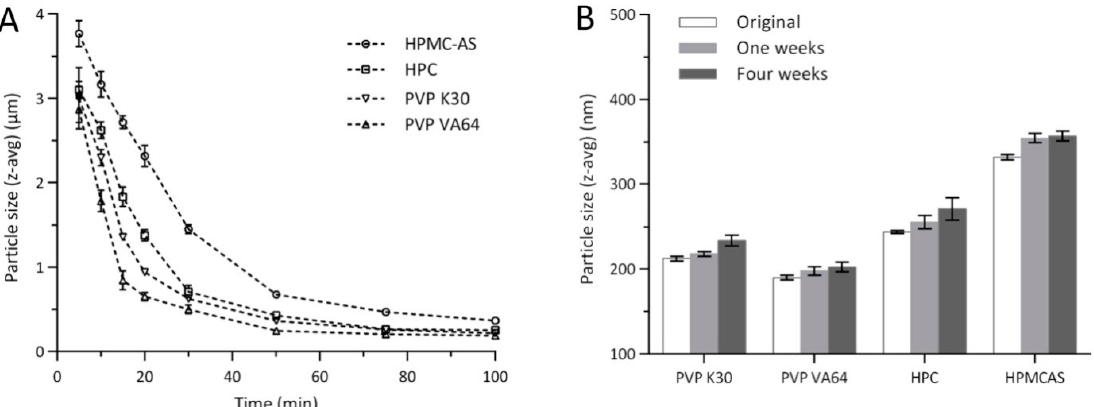
Figure 1. Particle size distributions during ( A ) milling process and ( B ) short-term storage process of celecoxib nanocrystalline (CLX-NC) containing different polymer stabilizers (mean ± SD, n = 3).